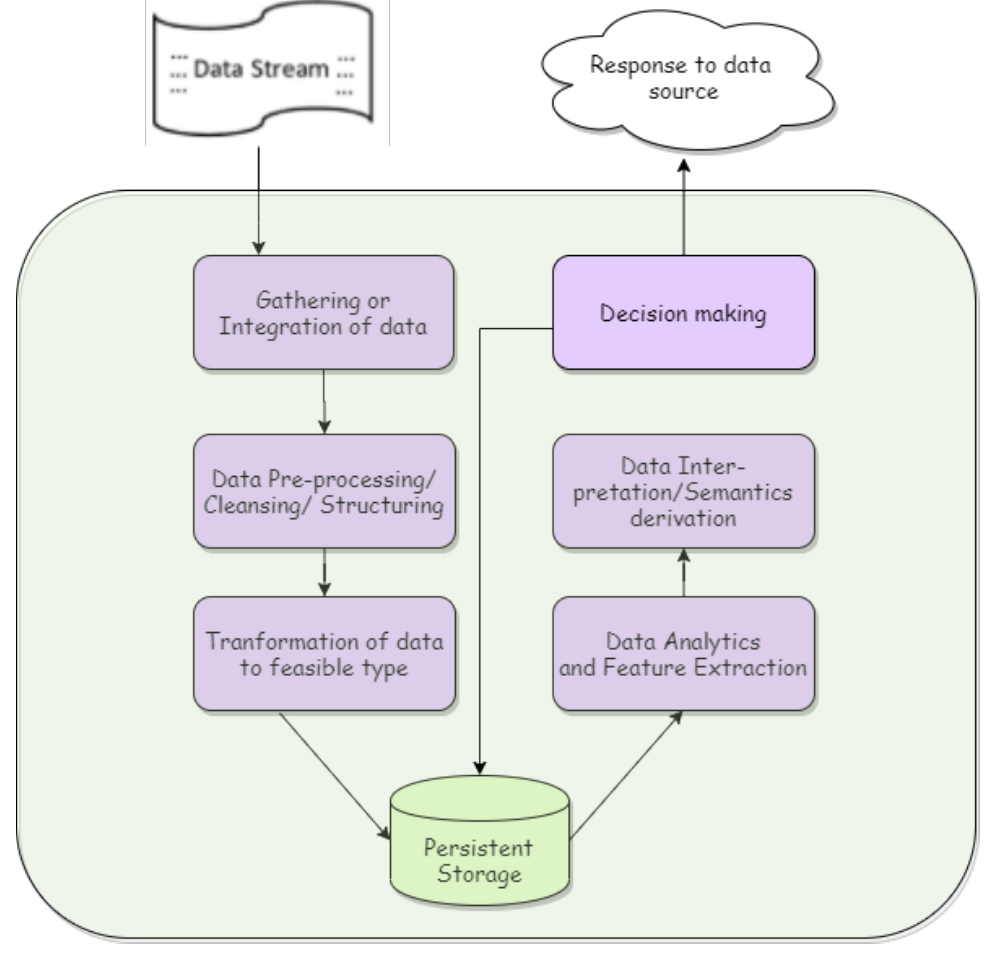
Figure 5. Flow diagram for data